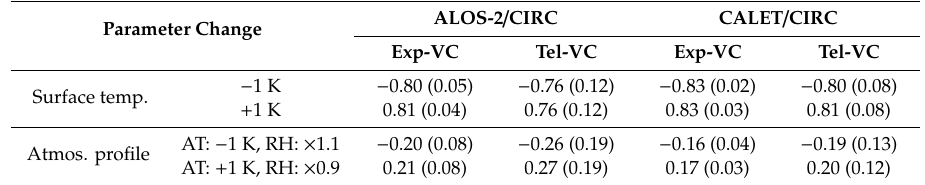
Table 2. The average and the standard deviation (in parentheses) of TOA brightness temperature change (in °C) induced by surface temperature changes (±1 K) or atmospheric profile changes (absolute shift of ±1 K in air temperature (AT) profile, and relative scaling of 10% in relative humidity (RH) profile) in Exp-VC and Tel-VC of each CIRC instrument.